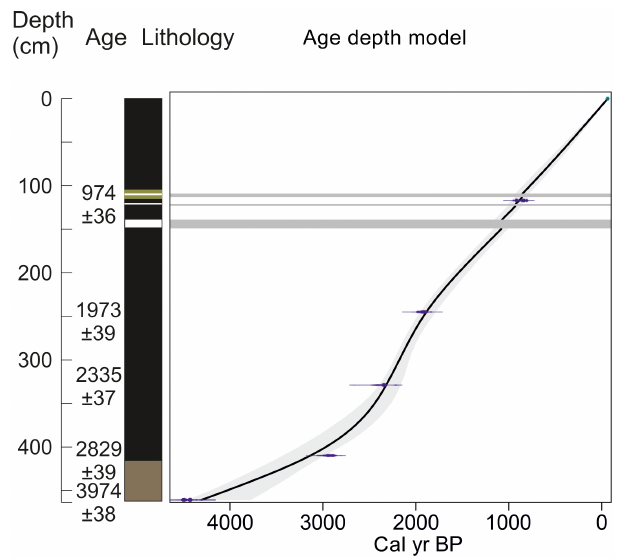
Figure 2. Sediment description, radiocarbon dates ( 14 C age) and age–depth models of Laguna Pindo. Key colour for sediment de- scriptions: black or dark brown – organic-rich sediments (peat and clay respectively); white – dark sandy intervals; green – greenish sandy clay, not